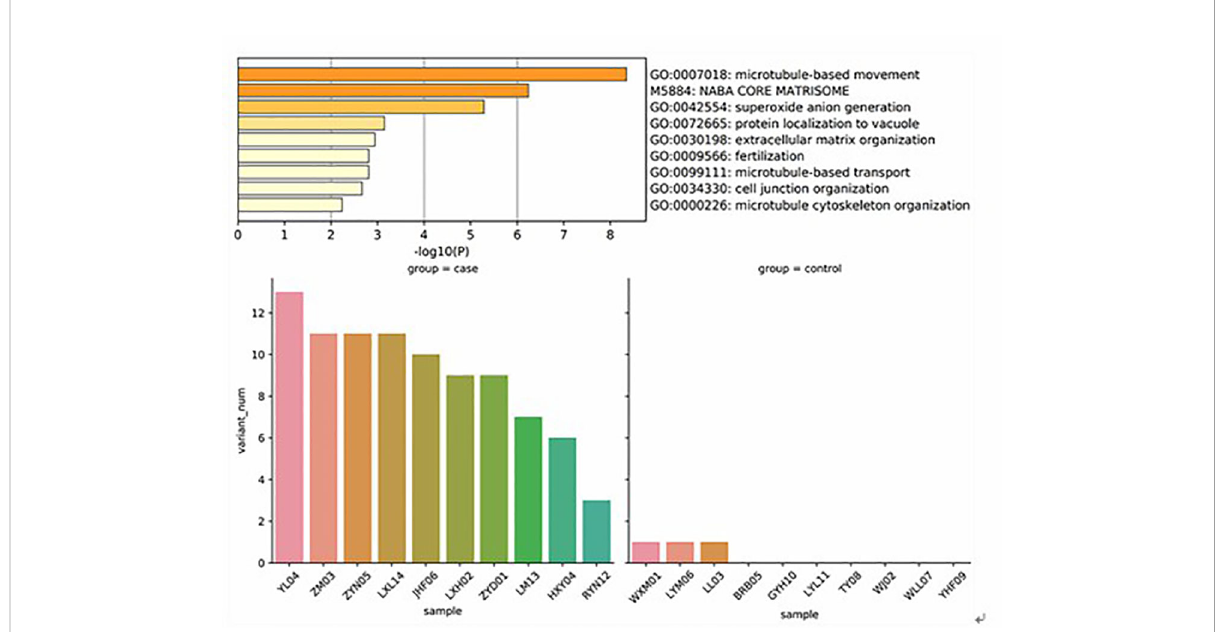
FIGURE 2 These genes were mainly enriched in microtubule based movement (GO: 0007018), NABA core matrix (M5884), superoxide anion generation (GO: 0042554), protein localization to vacuum (GO: 0072665), Extracellular matrix organization (GO: 0030198), utilization (GO: 0009566), microtubule-based transport (GO: 0099111), cell junction organization (GO: 0034330), microtubule cytoskeleton organization (GO: 0000226. It was found that the number of potentially harmful mutations carried by the case group was at least 5 loci and at most 13 loci; In the